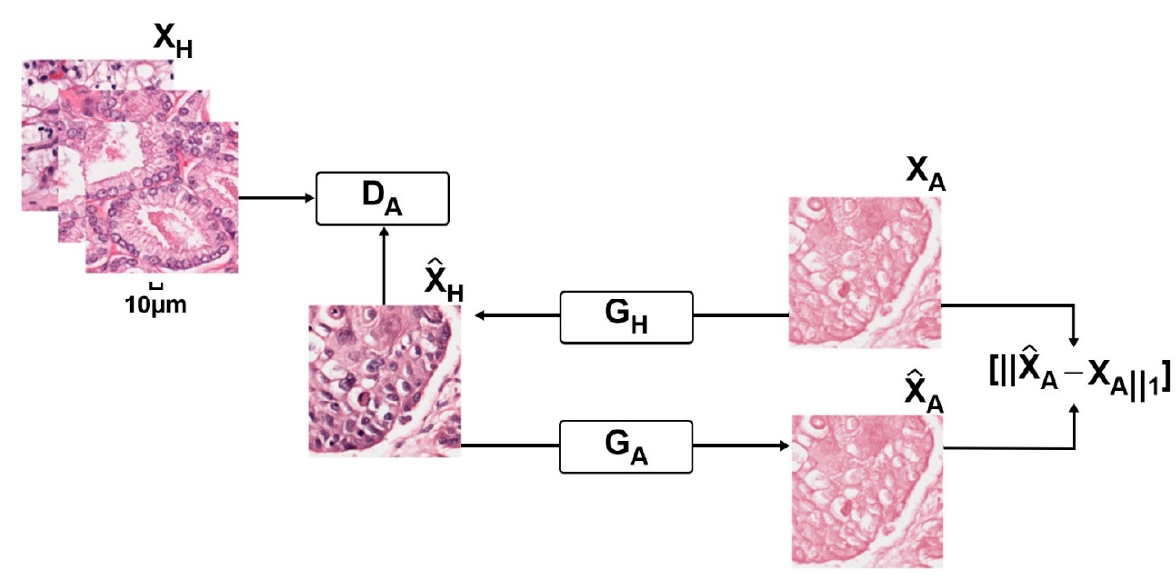
Figure 4. Stain style transfer for digital histopathological images.